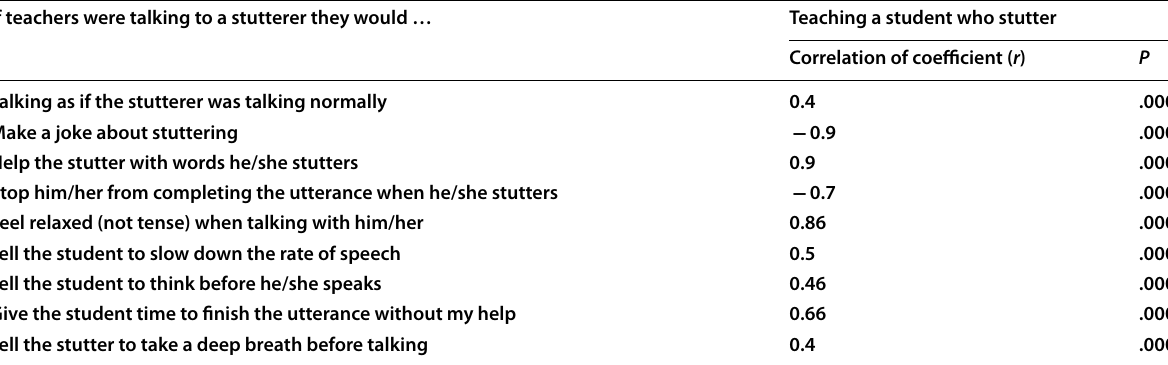
r , Pearson’s correlation, P * < 0.05 (significant), P ** < 0.001 (highly